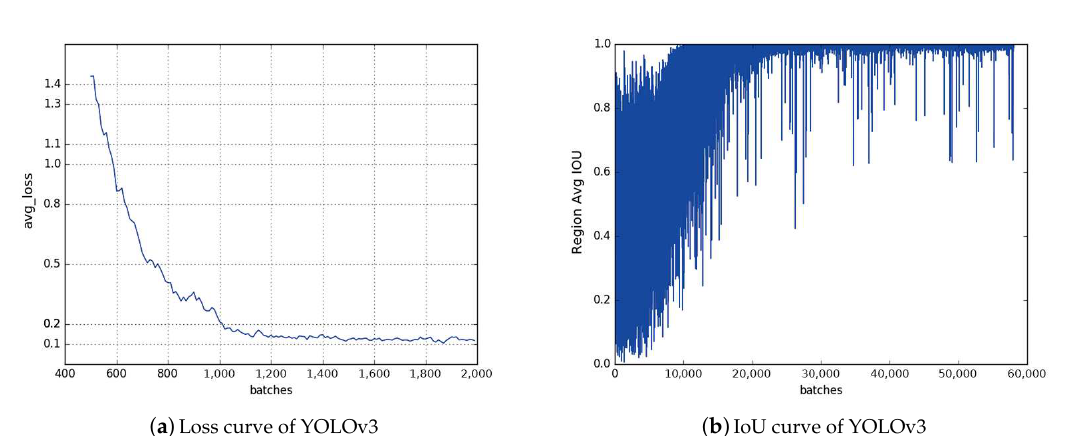
Figure 15. Loss and IoU curves of YOLOv3.